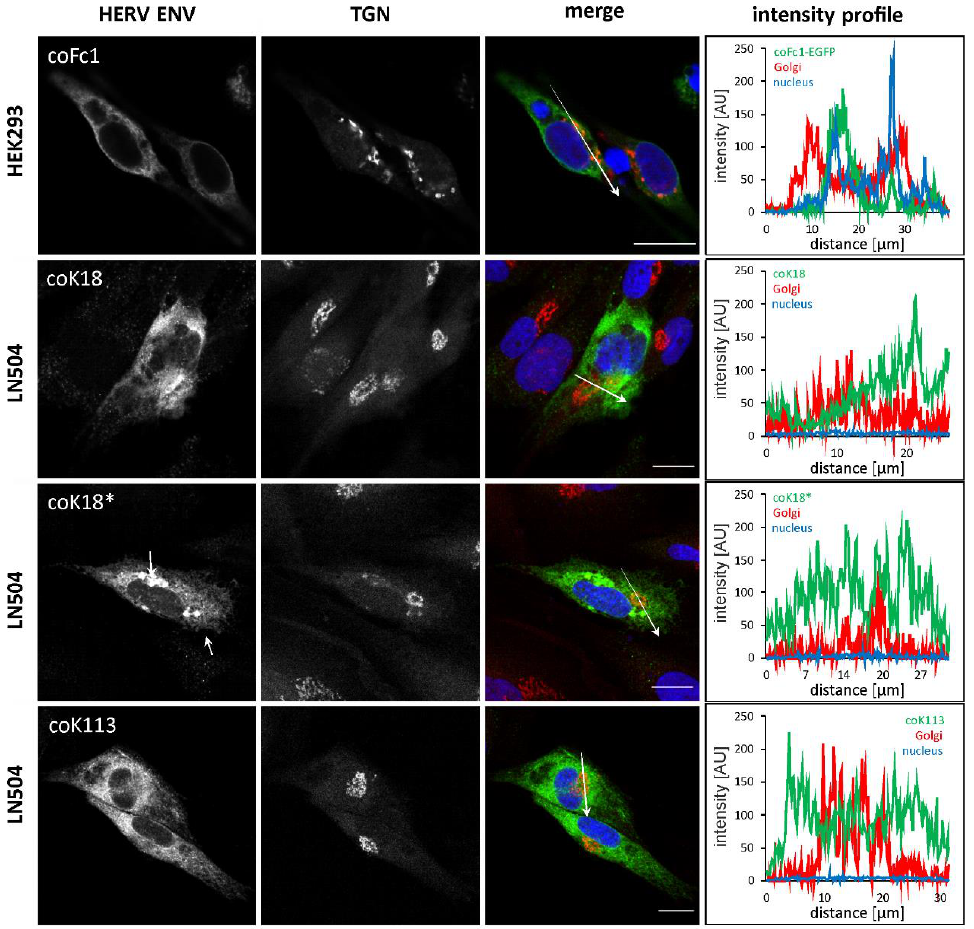
Figure 4. Localization of HERV ENV with trans Golgi network in transfected HEK293 and LN405 cells. Fluorescence microscopic images showing the subcellular localization of specified HERV ENV and the trans Golgi network (TGN) in transiently transfected HEK293 and LN405 cells. The merge image is a z-projection (maximum intensity) of the three recorded channels (green: HERV ENV, red: TGN, blue (DAPI): cell nucleus). Pixels with red and green fluorescence appear yellow. The graphs show a fluorescence intensity profile along the arrows drawn in the merge image. The detection of the envelope proteins was performed using anti-HERV-K-TM antibody HERM1811-5 for HERV-K and anti-FLAG for HERV-Fc1. The TGN was visualized by an anti-golgin-97 antibody for HERV-K and anti-GP73 antibody for HERV-Fc1. Scale bar: 20 µm.